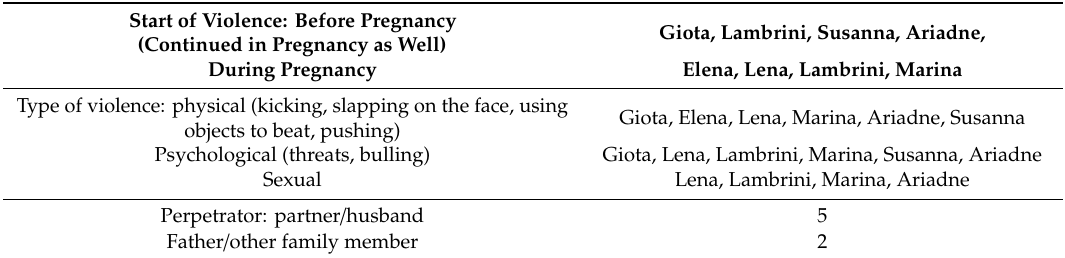
Table 3. Partner’s / husband’s